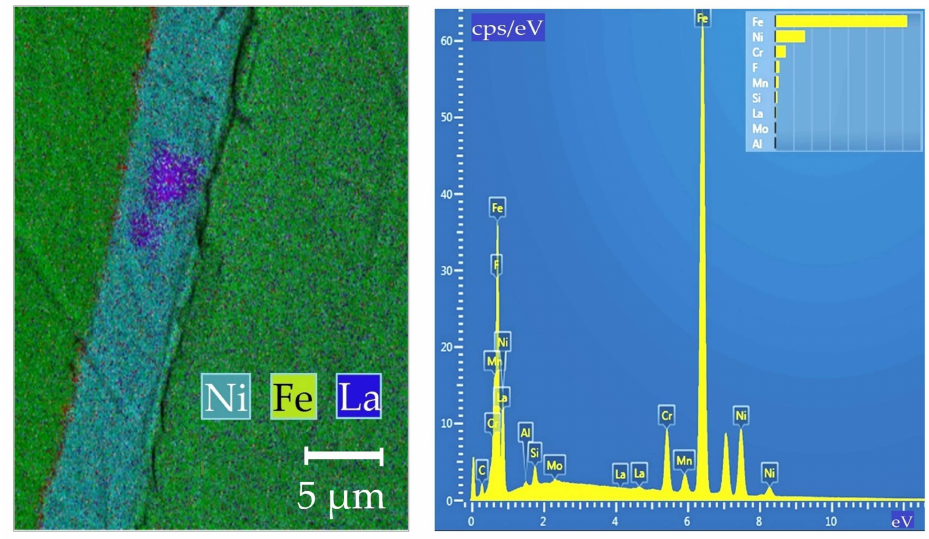
Figure 14. SEM-elemental mapping of Ni-LaF 3 composite coating. According to X-ray structural analysis, typical Ni-LaF 3 coating being about 5 µ m in thickness contains up to 1.6 wt.% of La; up to 2 wt.% of La 2 Ni 3 ; up to 0.2 wt.% of NiF 3 ; and up to 96 wt.% of Ni. The chemical analysis of weld metal in the weld center in 10HSND steel being 14 mm in thickness showed that as composite wires are applied, Cu, Ni, La, and Mn content insignificantly is increased. The content of other chemical elements did not change, as shown in Table